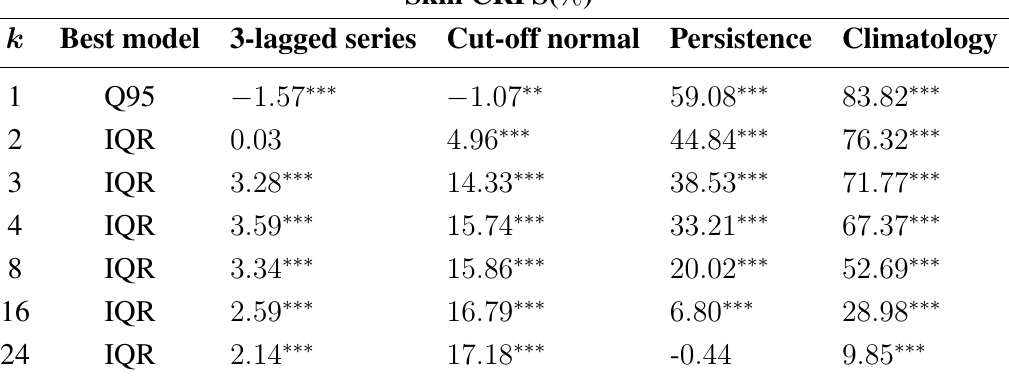
Table 13. The best performing model among the four competing ones, and its performance gain/loss with respect to the four reference (benchmark) models, for forecast horizon k (measured in 15 min steps). Reference models: 3-lagged series (column 3), Cut-off normal (column 4), Persistence (column 5) and Climatology (column 6). These results are outcomes from an averaged over 24-steps CFS optimization. The asterisks indicate the statistical significance of the gain/loss according to the Amisano and Giacomini test with the following significance codes for the p -value of the test: ***: p ≤ 0 . 01 , **: 0 . 01 < p ≤ 0 . 05